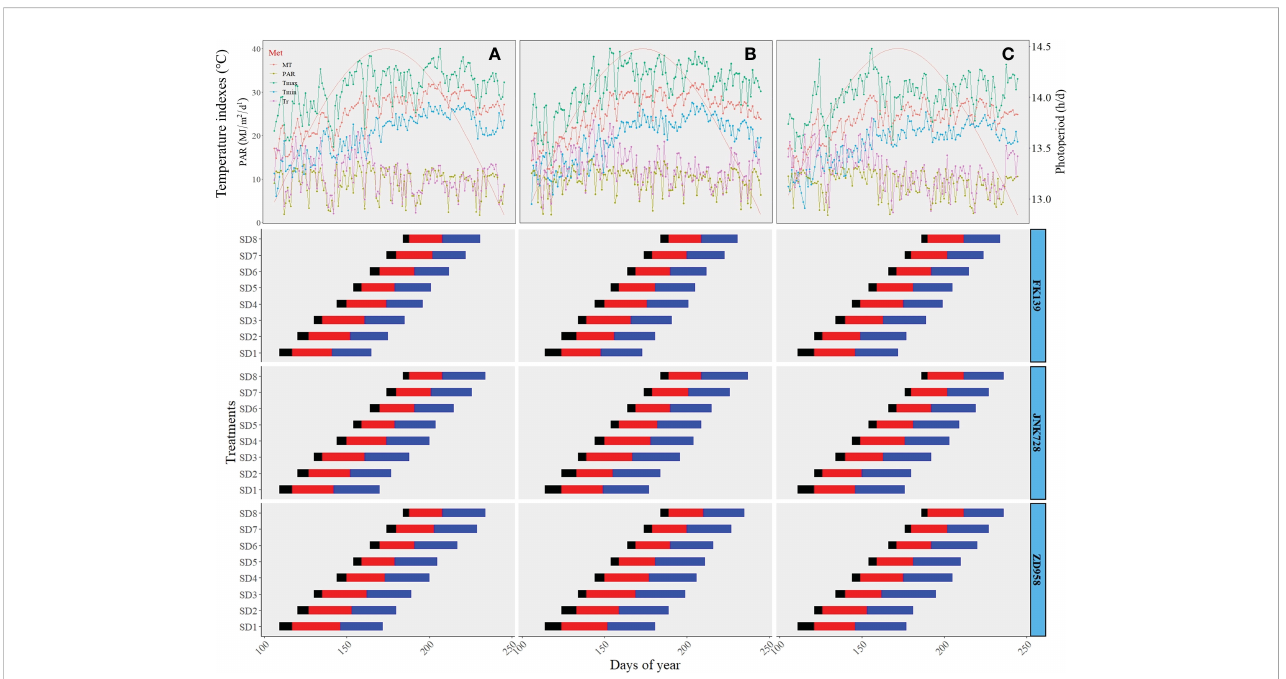
FIGURE 1 Time-course of meteorological conditions during maize vegetative growth. ( A – C ) respectively represent the meteorological conditions of 2018, 2019, and 2020, and the below horizontal bars indicate the duration (days) of maize phenological periods: black-bars indicate the time from sowing to emergence (V1), red-bars indicate the time fromV1 to V11 (The period of V1 to V11 nearly the time of maize leaf differentiation), blue-bars indicate the time fromV11 to silking (Xu et al.,